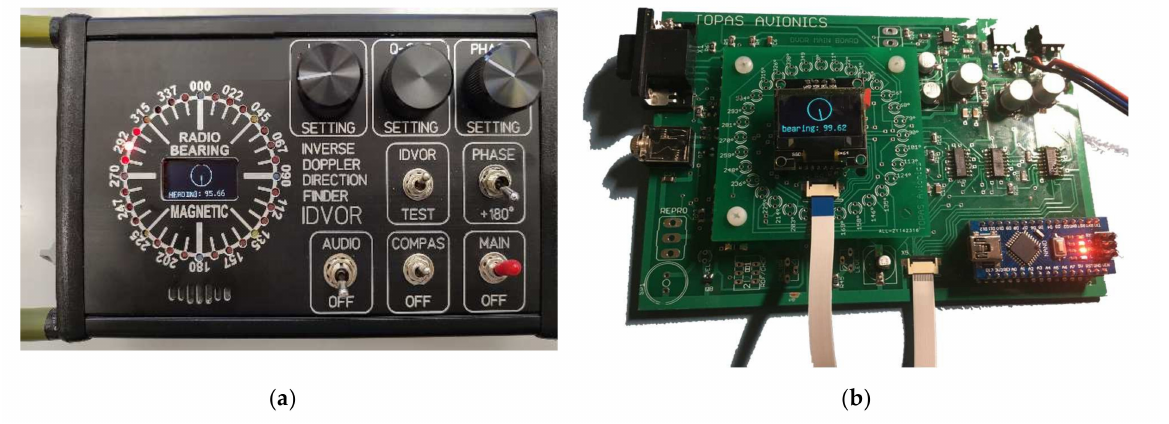
Figure 8. IDVOR control panel ( a ) and system board ( b